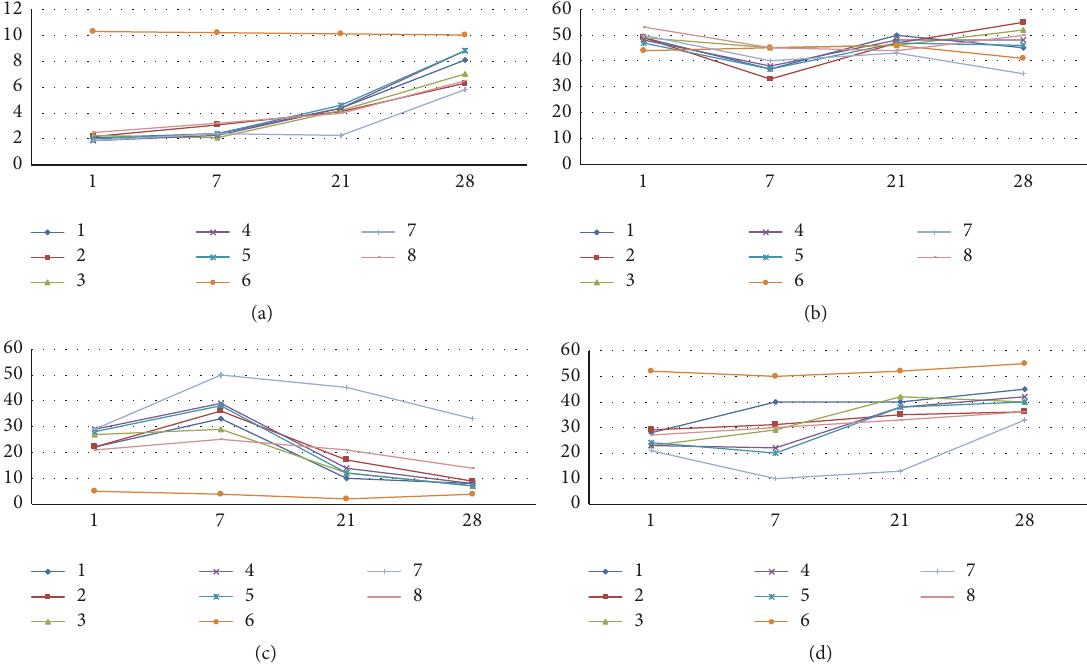
10 9 /L. The platelet level in the experimental groups was on average ( 0.48 ± 0.01 )% while in the control it was ( 0.35 ±